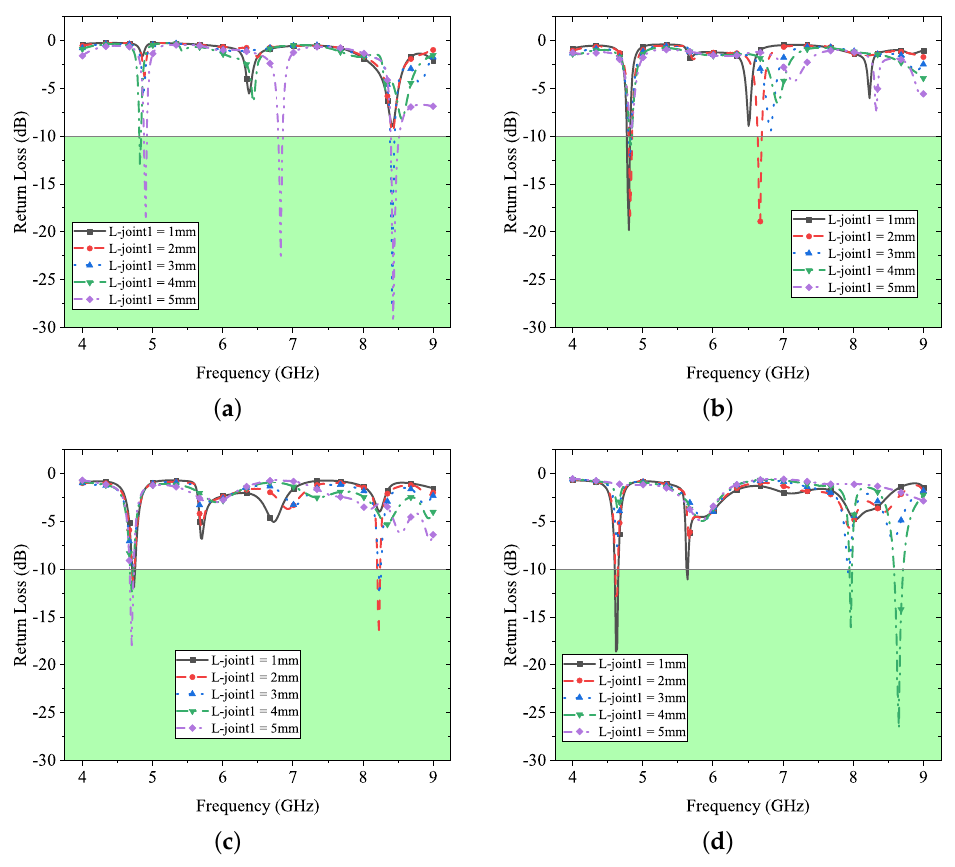
Figure 2. Effect of joint1 length ( L joint 1 ) on return loss performance. ( a ) Parametric sweep when Y joint 1 = 0 mm; ( b ) Parametric sweep when Y joint 1 = 2 mm; ( c ) Parametric sweep when Y joint 1 = 4 mm; and ( d ) Parametric sweep when Y joint 1 = 6